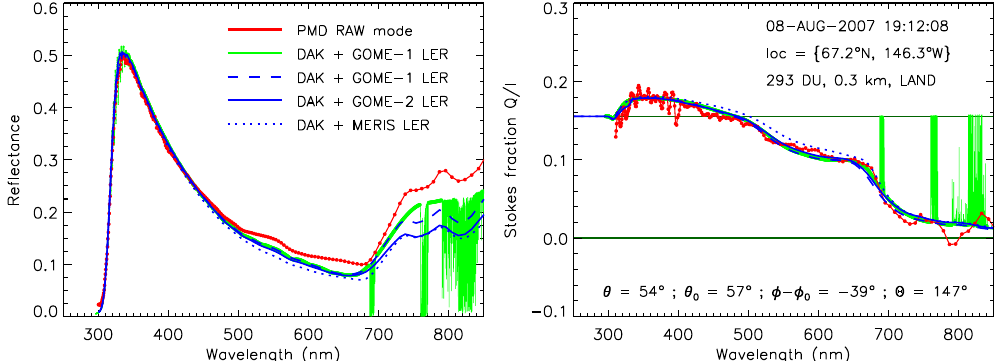
Figure 3. Earth reflectance (left panel) and polarisation Stokes fraction Q/I (right panel) derived from GOME-2 PMD RAW mode measure- ments for case 1 in Fig. 2 (in red). The green curves represent the high-resolution simulated reflectance and polarisation spectra, based on Fig. 3. Earth reflectance (left window) and polarisation Stokes fraction Q/I (right window) surface albedo input from the GOME-1 surface LER database. The dashed blue curve represent the same, but convolved with the PMD slit function. The FWHM of this slit function typically ranges between 3nm in the UV up to 35nm in the NIR. The solid and dotted blue curves derived from GOME-2 PMD RAW mode measurements for case “1” in Fig. 2 (in red). The also represent convolved simulation results but for these simulations the surface albedo input was taken from the GOME-2 and MERIS surface reflectivity databases, respectively. The two horizontal green lines in the right panel indicate the unpolarised situation, for which Q/I = 0, and the single scattering situation, for which Q/I = (Q/I) ss based on surface albedo input from the GOME-1 surface LER database. The dashed blue